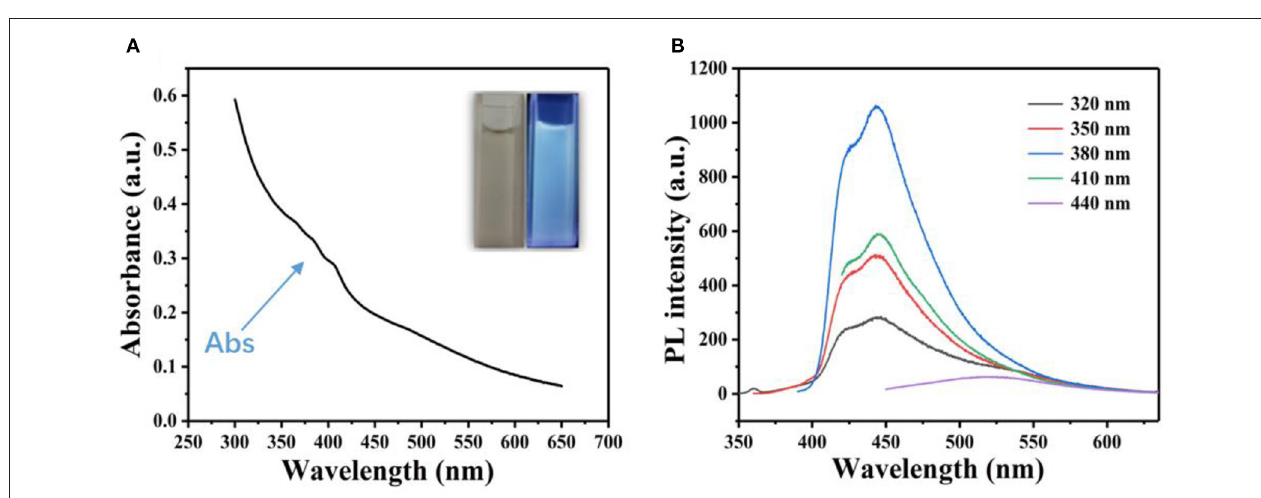
FIGURE 1 | Spectrophotometric characterization of GQDs. (A) UV spectrum of an aqueous suspension of GQDs. Inset: aqueous suspension of GQDs under natural light (left) and blue fluorescence upon excitation by a 365nm UV lamp (right). (B) Fluorescence spectra of GQDs at different excitation wavelengths.